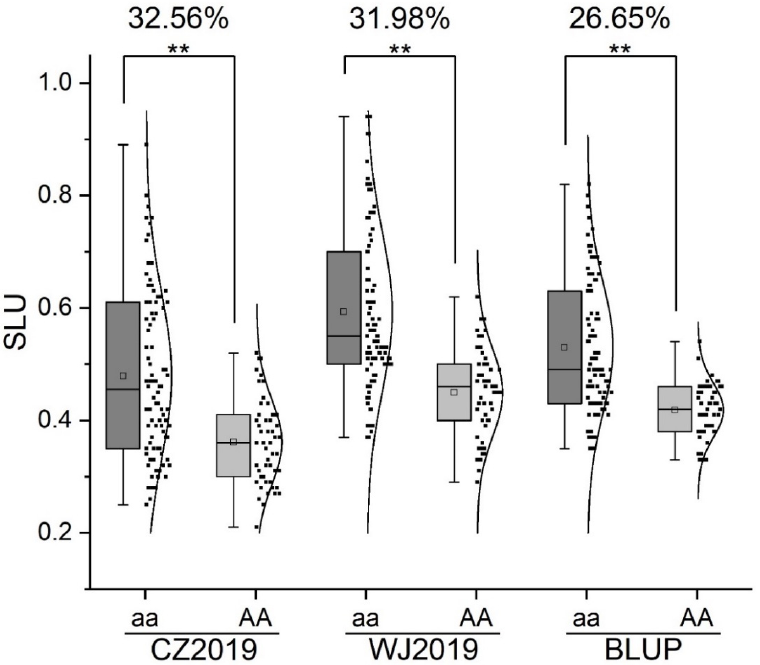
Figure 3. Effects of Qslu.sicau-2B-2 in the H461 × CM42 recombinant inbred line population. Aa, lines carrying the homozygous alleles from H461. AA, lines carrying the homozygous alleles from the non-H461 parents. CZ2019 and WJ2019 denote the field experiments in 2019 in Chongzhou and Wenjiang, respectively. BLUP, best linear unbiased prediction. **, significant at p < 0.01. Table 4. The primers of the kompetitive allele-specific marker for alleles of Qslu.sicau-2B-2 that were used in this study.